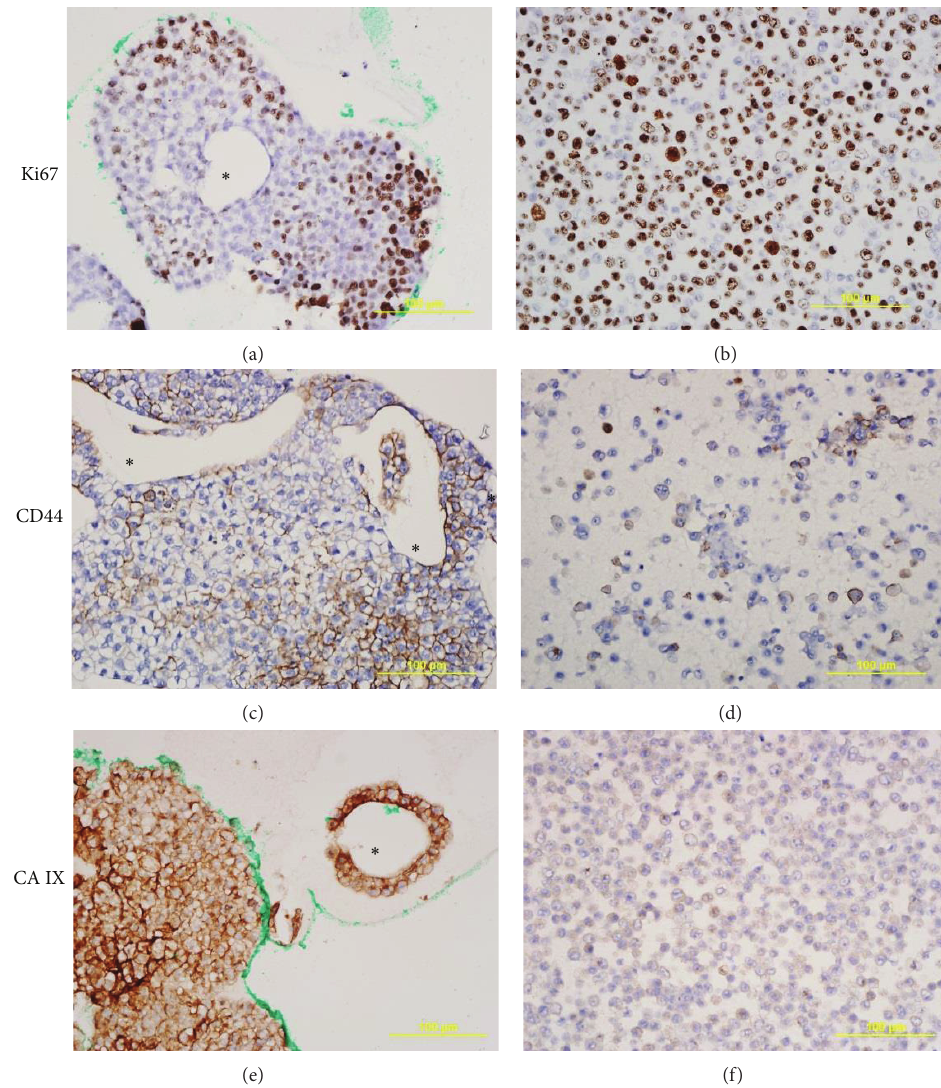
Figure 7: The images are representative of immunohistochemistry staining of nuclear staining of proliferation marker Ki67, membrane protein CD 44, and CA IX. The images of scaffold culture (left panel) are compared with cell pellet paraffin section (right panel). The scaffold dissolved in xylene presented as a clear region marked ∗ . All scale bars are 100 𝜇 m, magnification